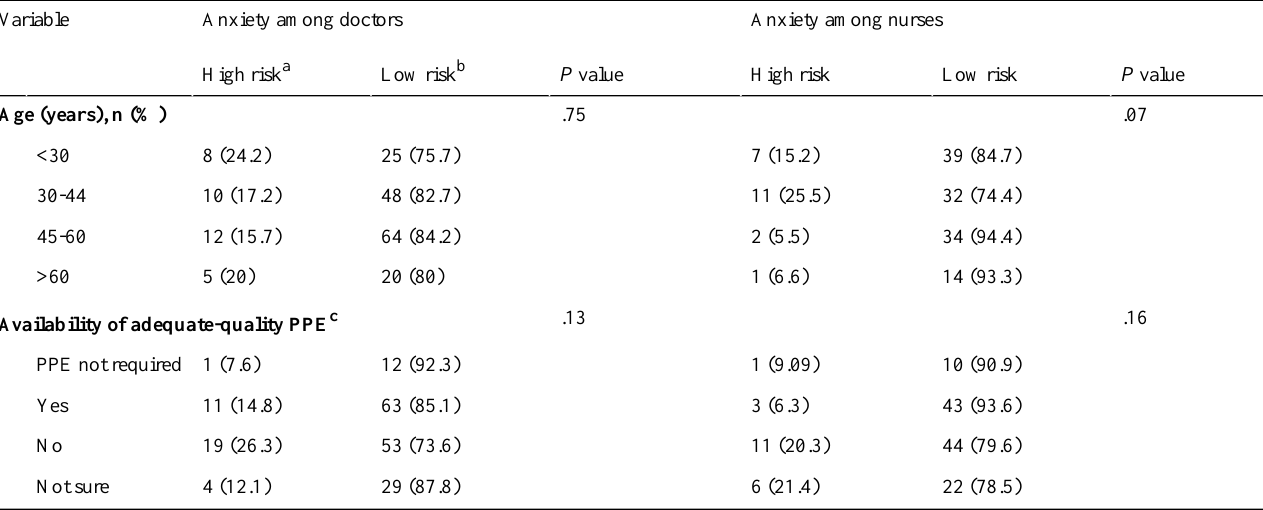
Table 2. Anxiety levels among doctors and nurses with regard to age and availability of personal protective equipment, determined based on Generalized Anxiety Disorder, 7-item (GAD-7) score.